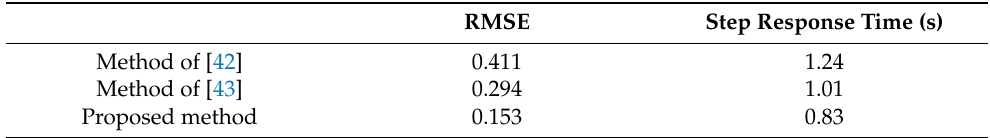
Table 5. Comparison based on RMSE and step response time.